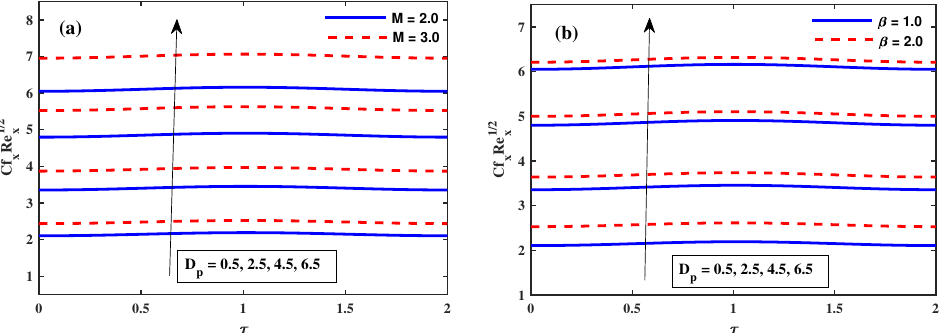
Figure 6. Fluctuation of Cf x Re 1/2 x against D p (nanoparticle radius), ( a ) M (magnetic field), and ( b ) β (material parameter).